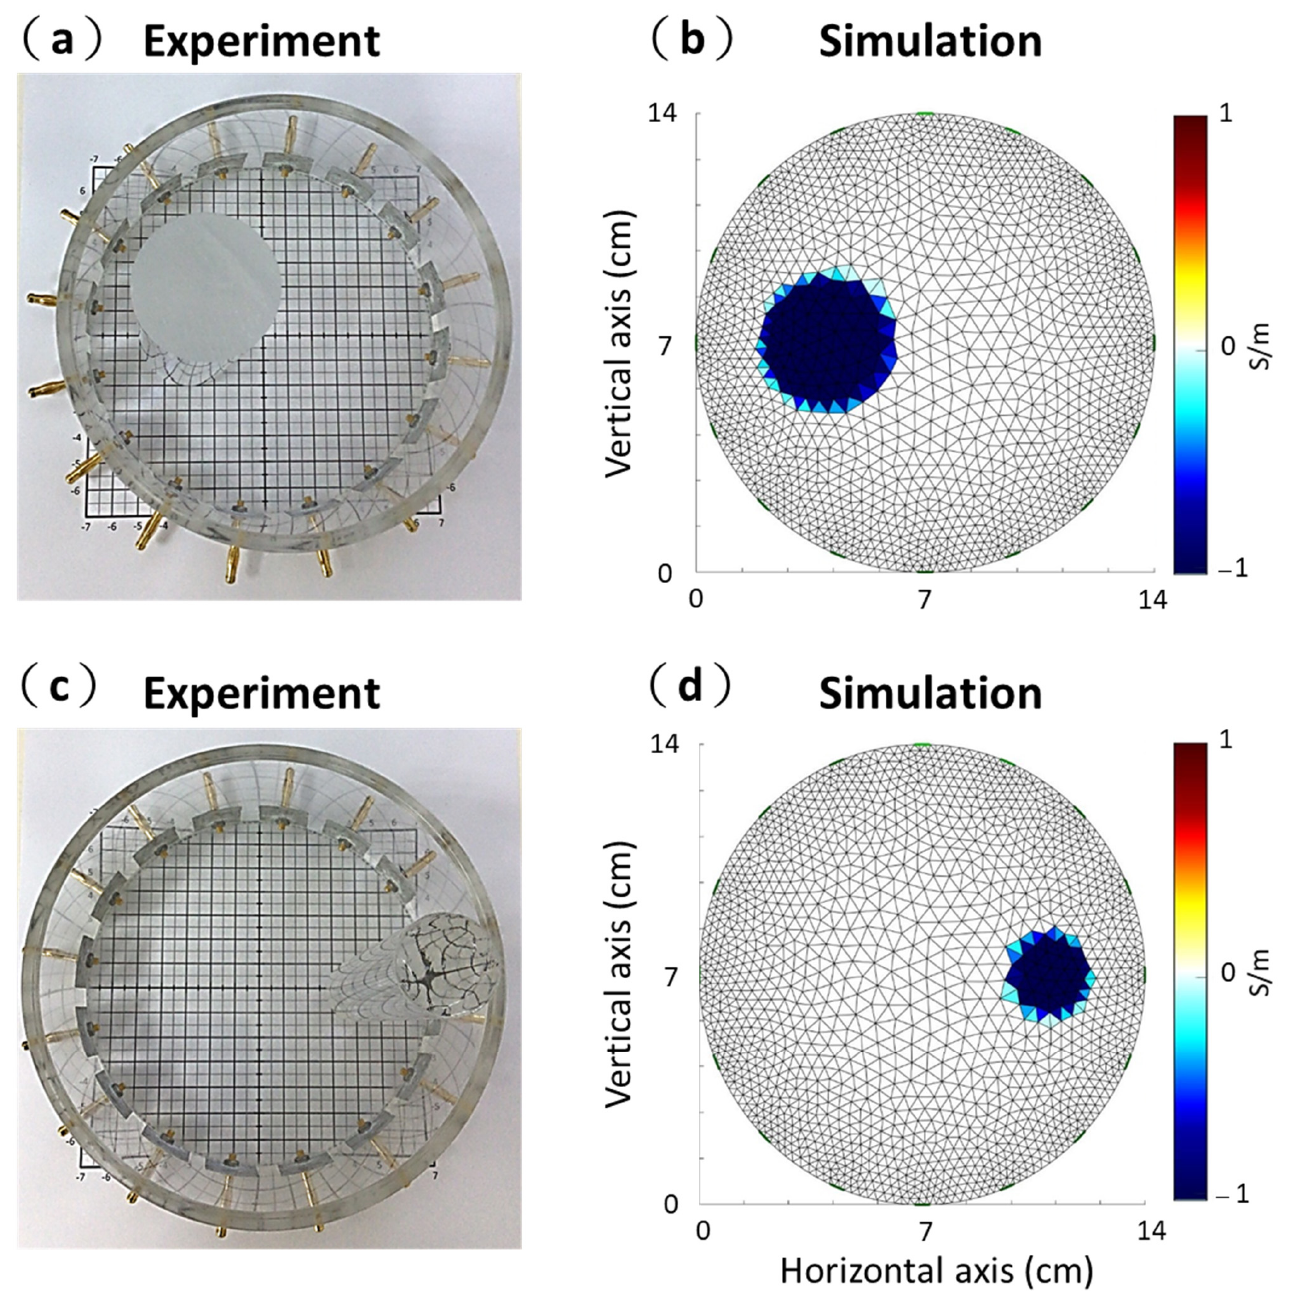
Figure 2. Experimental phantom and simulation setup. ( a ) An acrylic rod with a diameter of 4 cm in the acrylic cylinder. ( b ) A conductivity contrasting inclusion with a diameter of 4 cm using a 2D finite element model. ( c ) An acrylic rod with a diameter of 2.5 cm in the acrylic cylinder. ( d ) A conductivity contrasting inclusion with a diameter of 2.5 cm using a 2D finite element model.